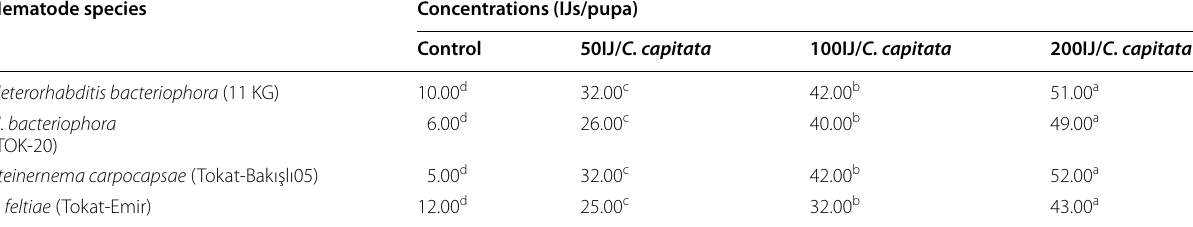
CV: 0.56, LSD: 5.47 Means followed by the same letter are not statistically different according to the Duncan test ( P